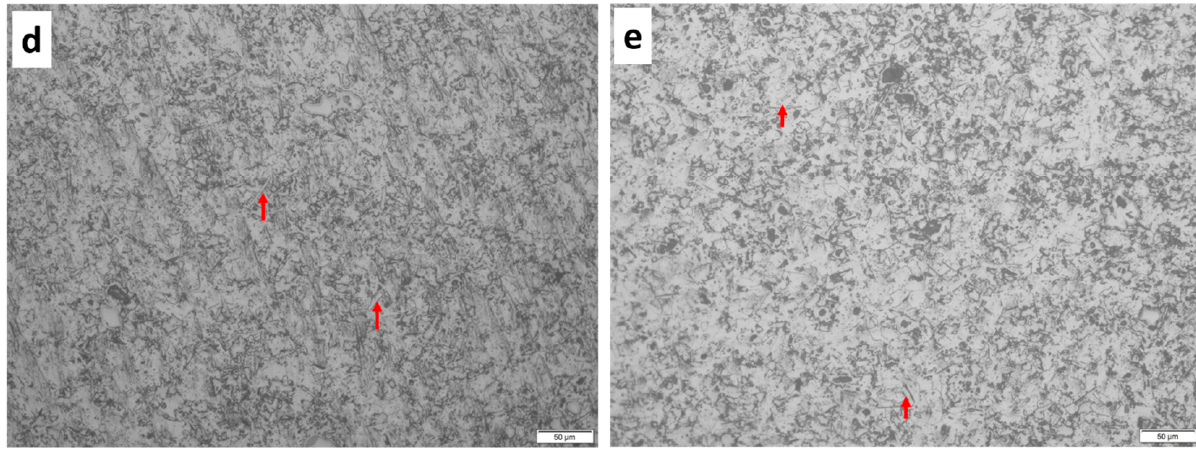
Figure 5. Optical images of the sintered samples ( a ) T0.0, ( b ) T2.5, ( c ) T5.0, ( d ) T7.5, and ( e ) T10.